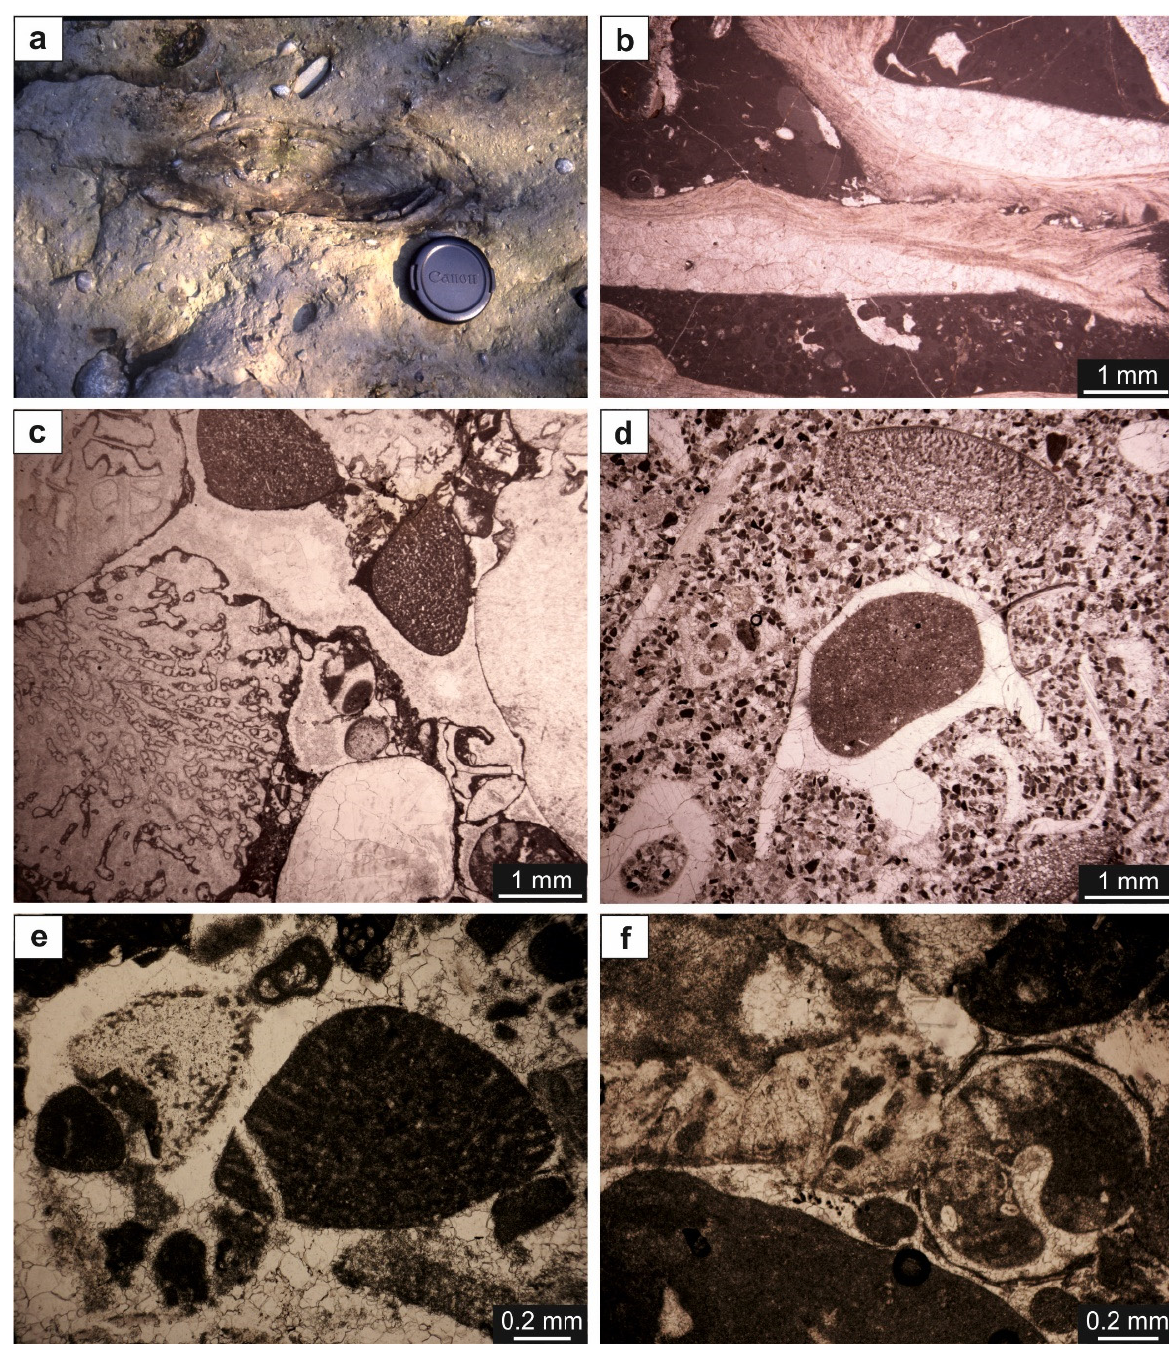
Figure 4. Outcrop of gravelstones of the Kremna Formation of the Magura Nappe (upper Oligocene/lower Miocene) (Czarna Woda stream, Jaworki village) ( a ) with Urgonian exotics ( b – f ): ( b ) fragments of rudists shells; ( c ) grainstone with corals and orbitolinids; ( d ) biodetritic sandy limestones with orbitolinids; ( e ) grainstone with benthic forams, including orbitolinids, and echinoderm elements; ( f ) grainstone with bioclasts, including gastropods.